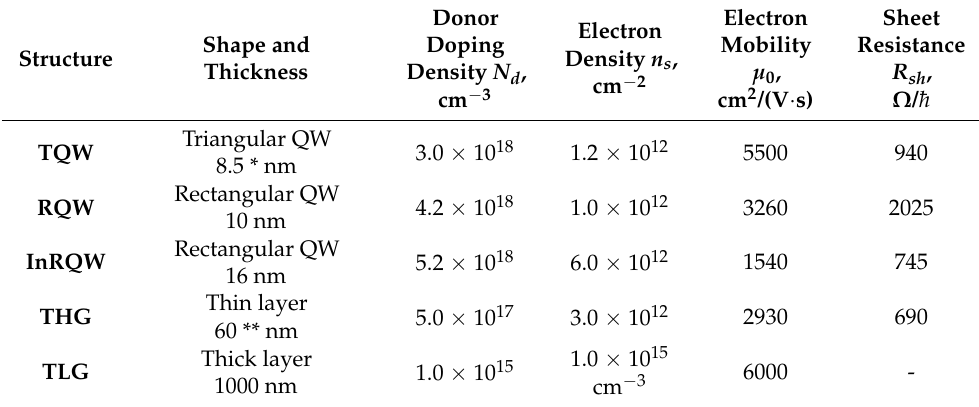
Table 1. The geometrical and electrical parameters of the investigated semiconductor structures.